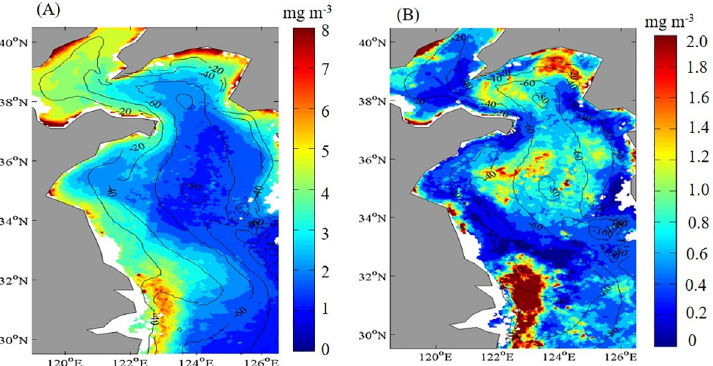
Fig 2. Spatial patterns of temporal means in the Yellow Sea, China. (A) Chlorophyll- a concentration (Chl- a ) and (B) the Chl- a standard deviation map during 2003–2015.